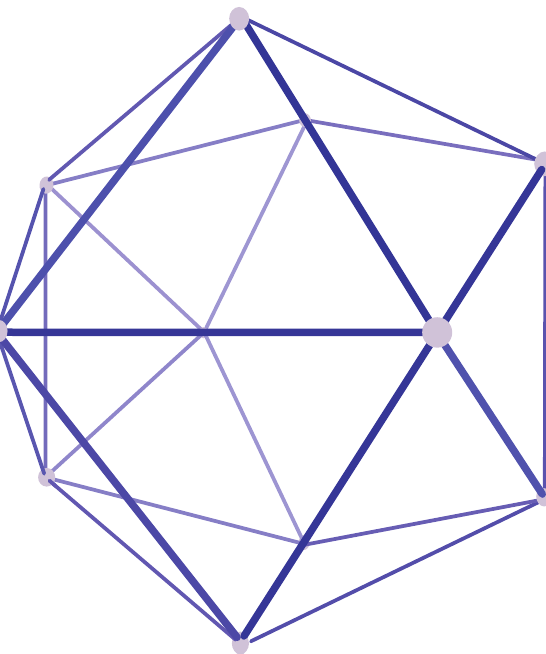
Figure 7: The regular